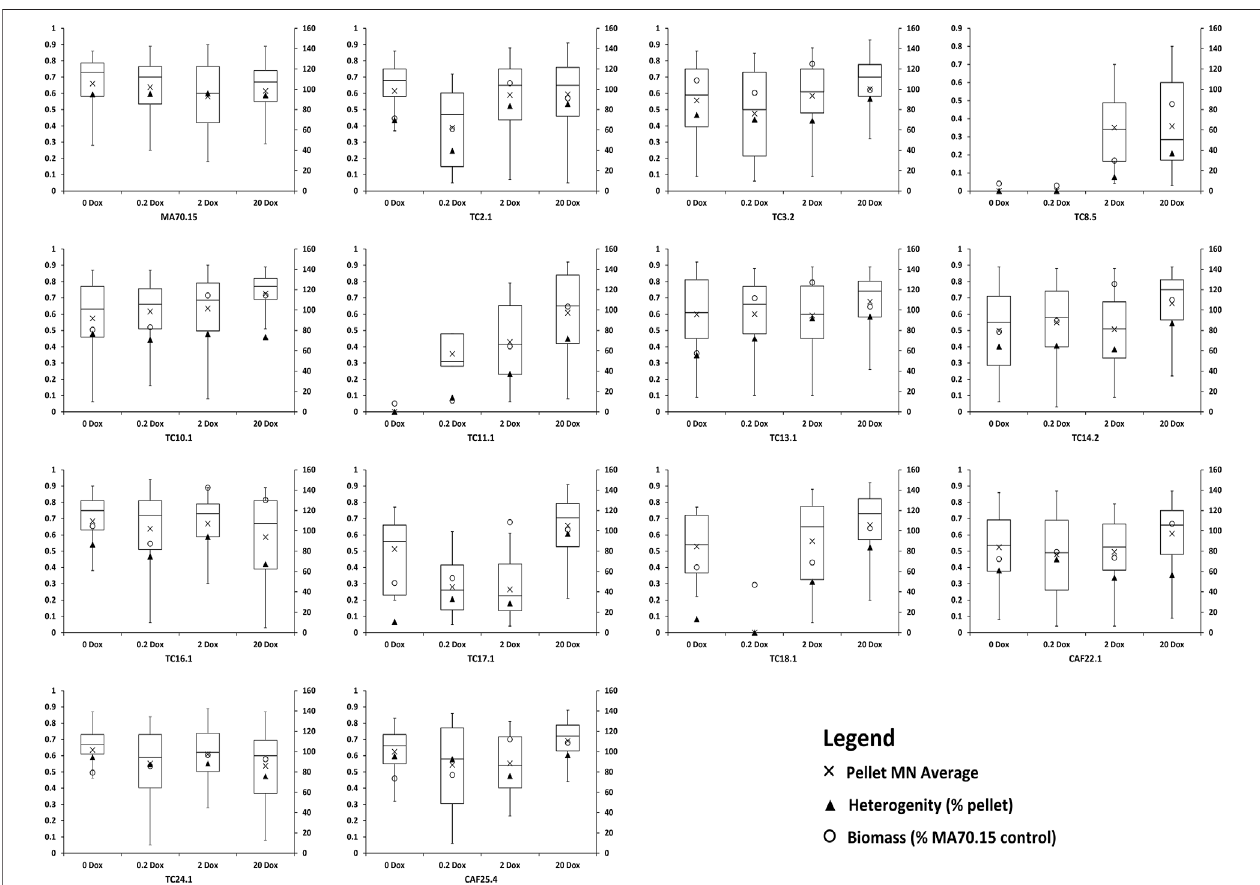
FIGURE 3 | Quanti fi cation of culture heterogeneity, biomass, and pellet MNs following titration of respective morphogene expression during liquid fermentation. Leftaxis:MN,whichvarybetween0 – 1andarerepresentedbyboxplots.AverageMNvaluesaredepictedbyacross,withthemiddlehorizontallinedepictingthemedian MN. Right axis: Heterogeneity is given as a percentage of pellets for the total culture (see Materials and Methods section). Biomass is given as a percent of MA70.15 control at the respective Dox concentration.